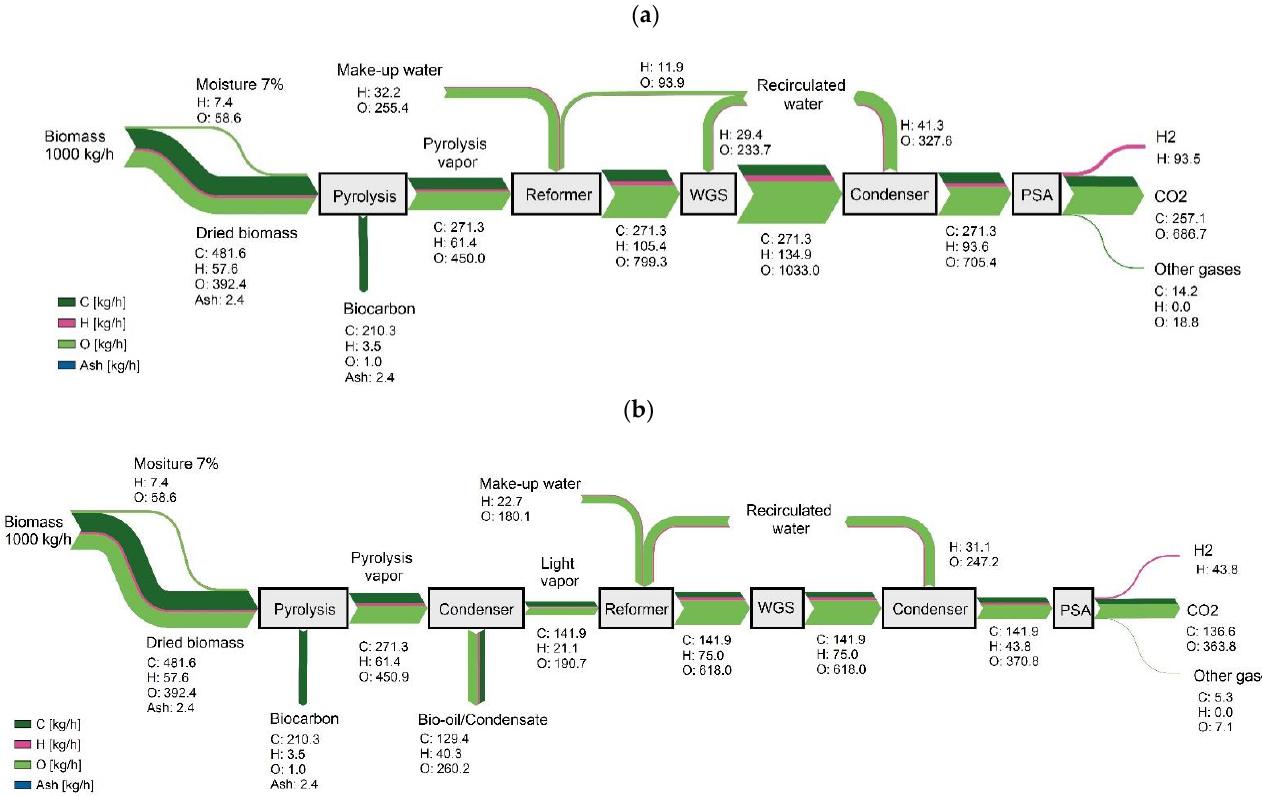
Figure 6. Mass flow diagrams for production scheme of ( a ) biocarbon and H 2 (scheme 1); and ( b ) biocarbon, bio-oil, and H 2 with condenser temperature of 50 °C (scheme 2).